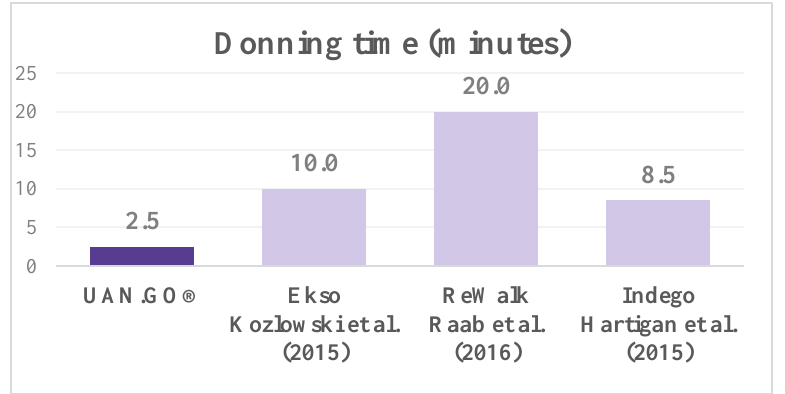
Figure 5. Donning times comparison between Uan.Go, Ekso [36], ReWalk [37] and Indego [38] exo- skeletons.